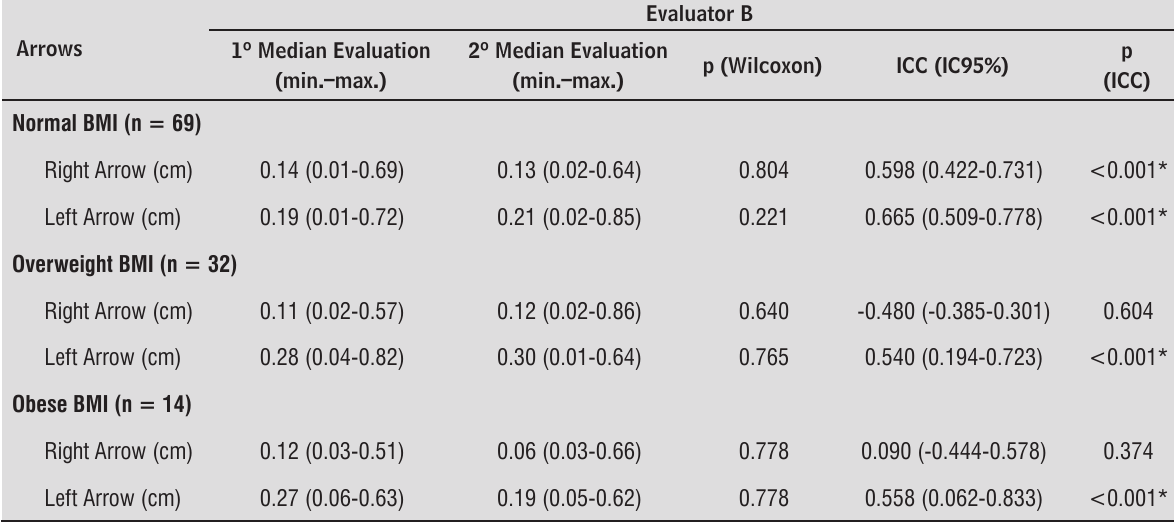
Table 1B - Results of the Vert 3D Version 1 regarding to the scoliosis arrows repeatability in the various nutritional